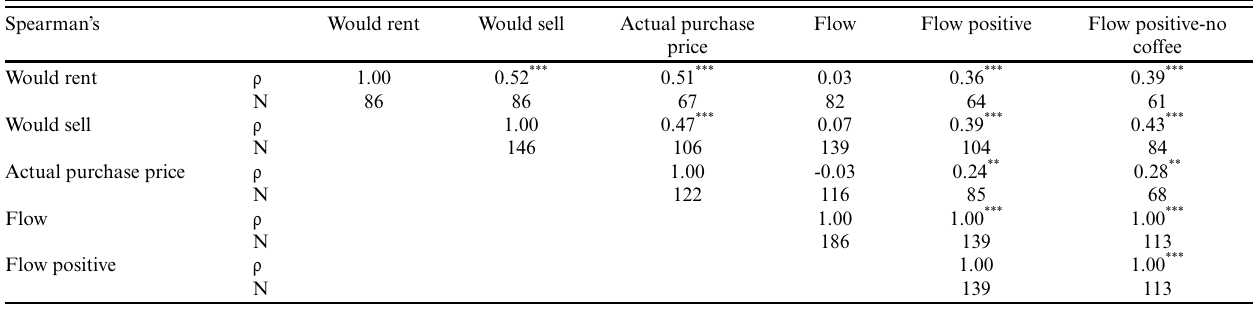
Table 4 . Correlation (Spearman’s ρ ) between would rent, would sell, actual purchase price, flow, flow positive, and flow positive-no coffee estimates. *** α = 0.01, ** α = 0.05.